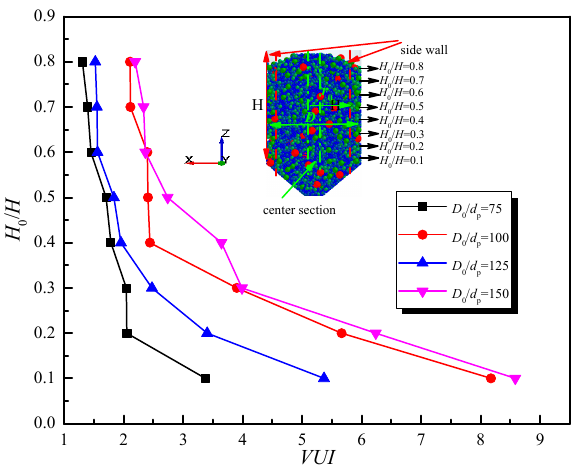
Figure 24. The variation in VUI with sinter layers for different geometry factors.